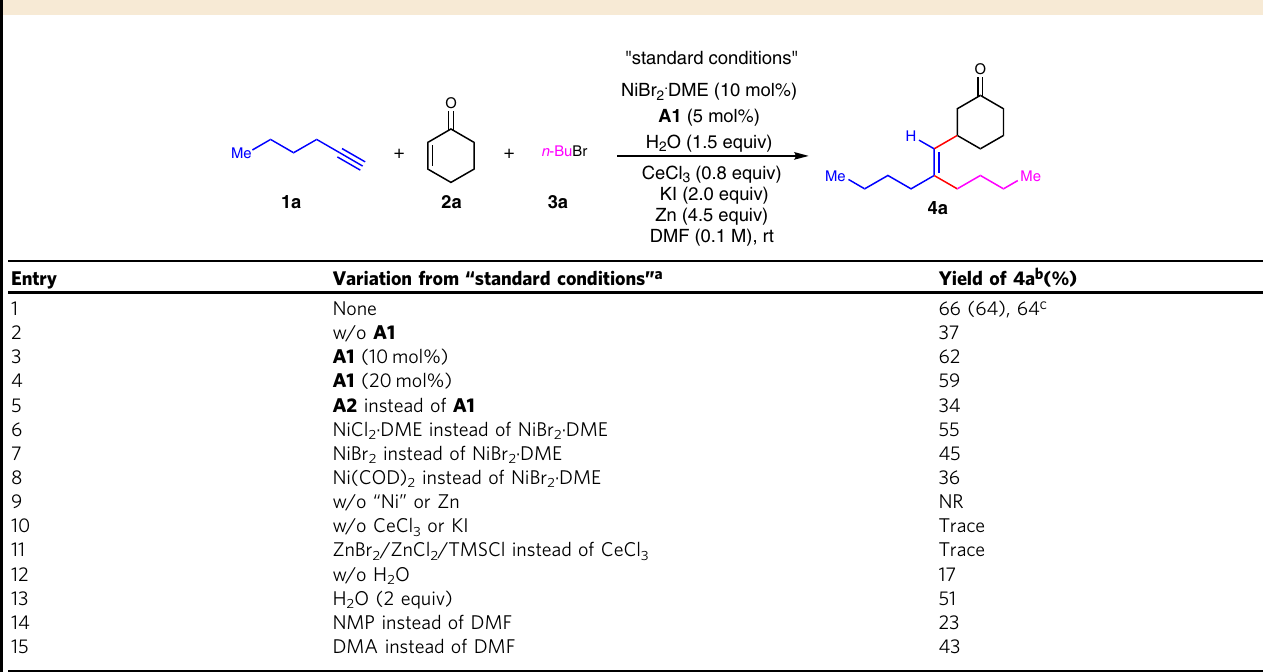
Table 1 Condition evaluation for the fully intermolecular cross-electrophile dialkylation of